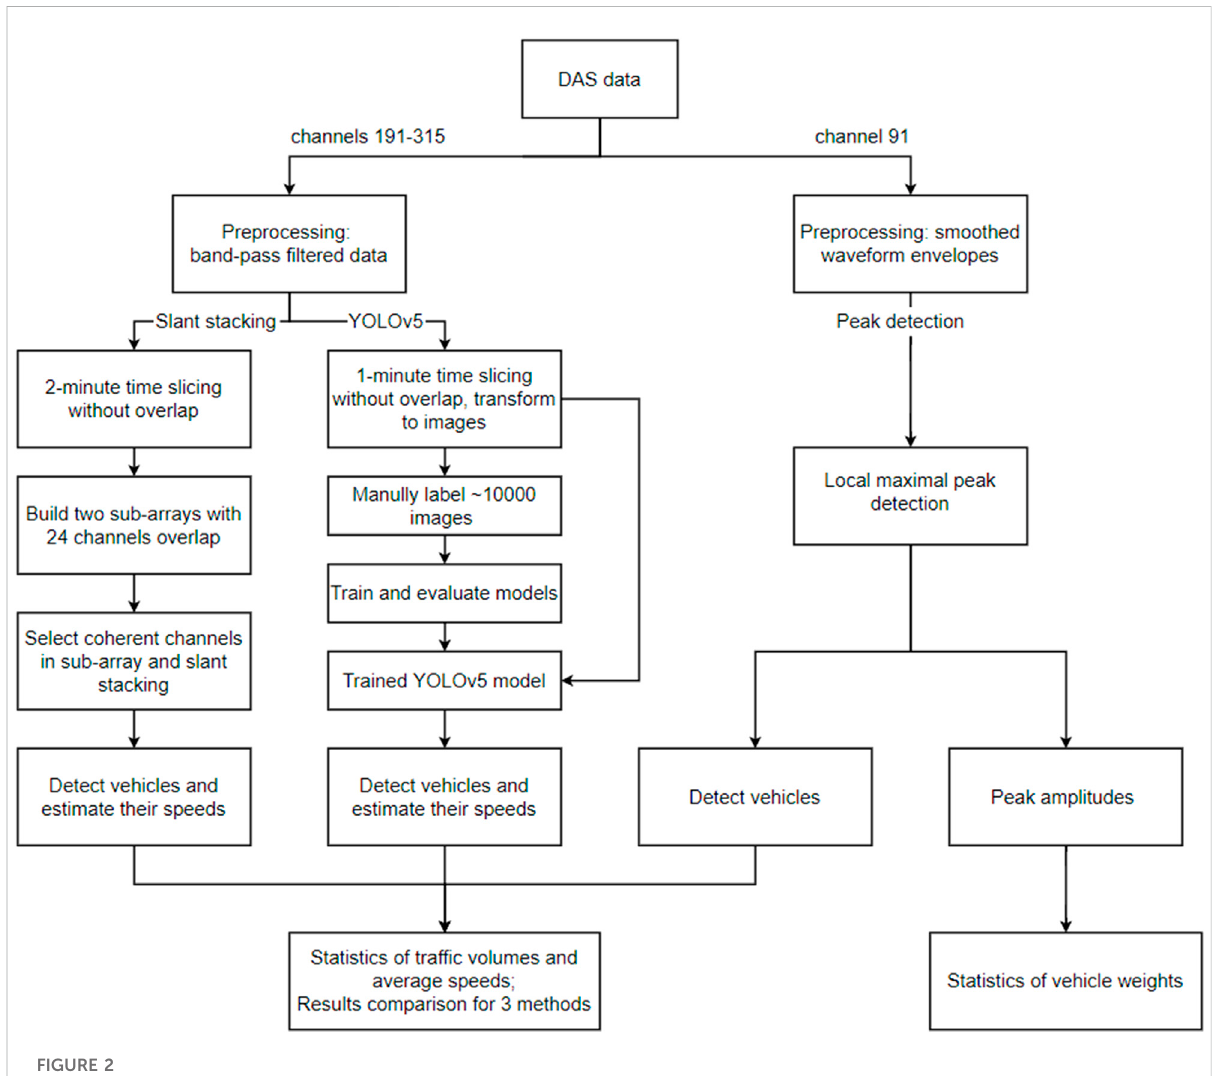
FIGURE 2 Overall data processing fl